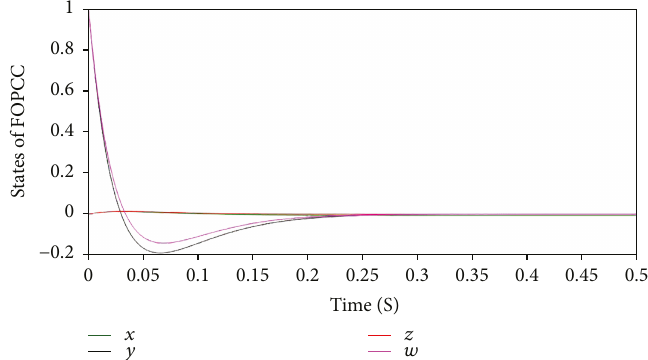
Figure 8: The time history of the controlled states of the FOPCC